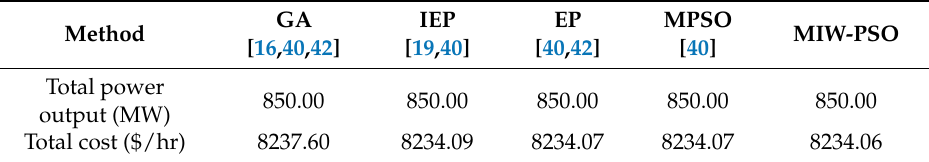
Table 6. Simulation result comparison on the second case study.